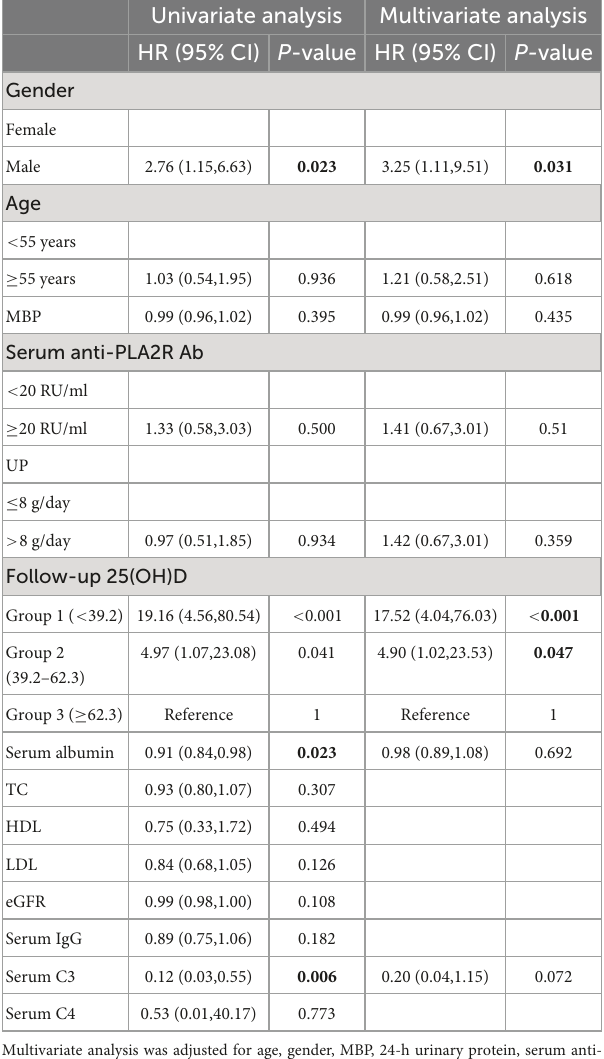
TABLE 5 Risk factors of non-remission in PMN determined by univariate and multivariate Cox regression. Univariate analysis Multivariate